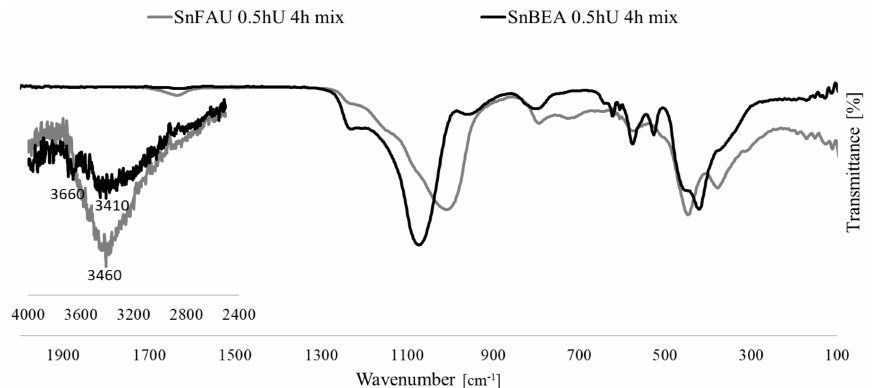
Figure 5. FT-IR spectra of SnFAU 0.5 h U 4 h and SnBEA 0.5 h U 4 h.